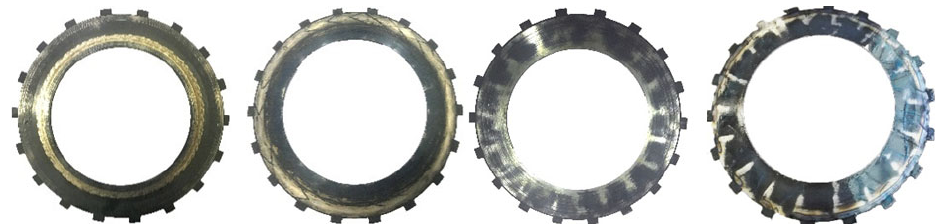
Figure 1. Wear of the deformed separate